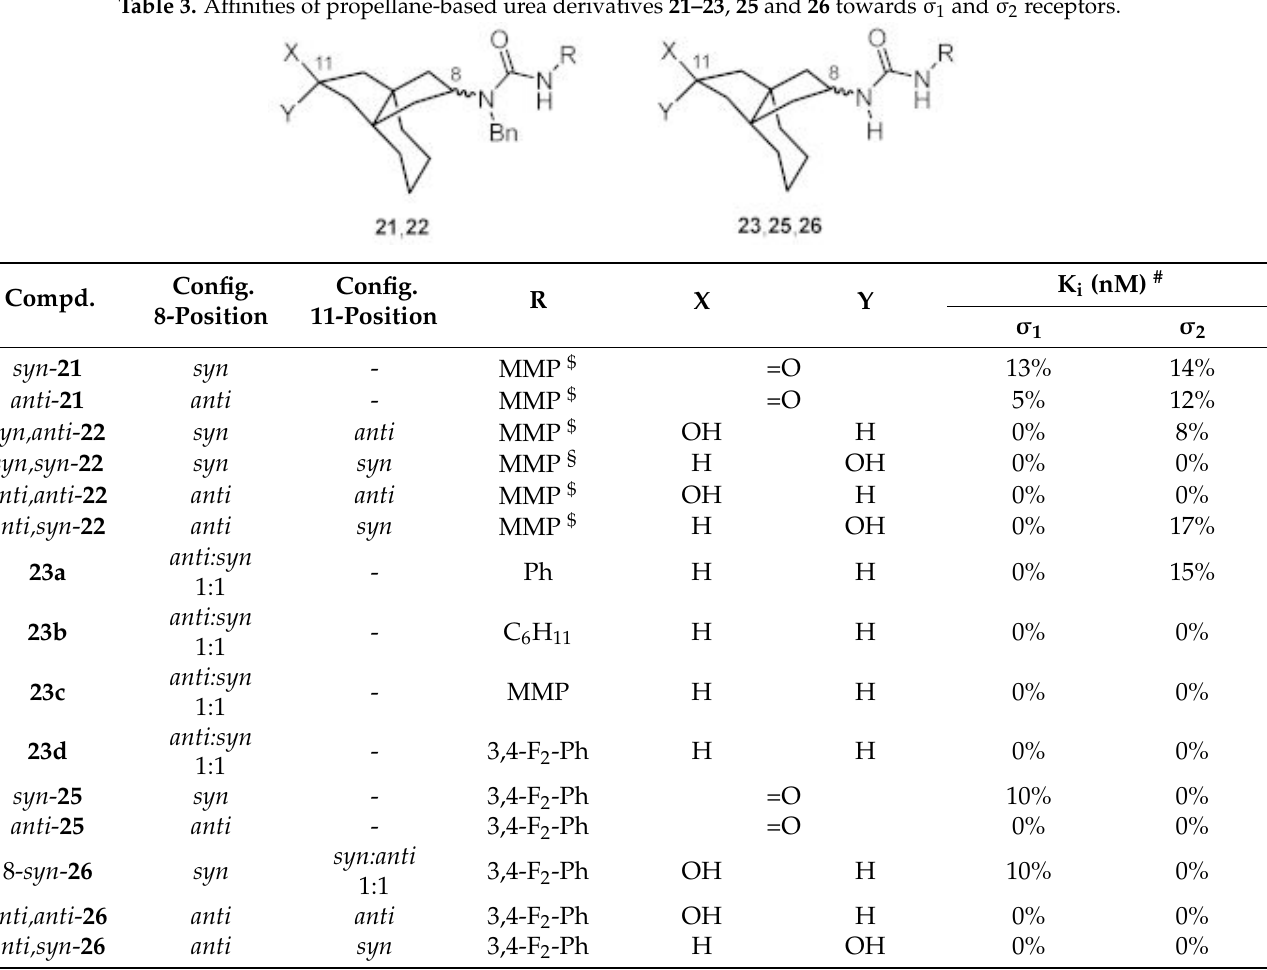
Table 3. Affinities of propellane-based urea derivatives 21–23 , 25 and 26 towards σ 1 and σ 2 receptors.